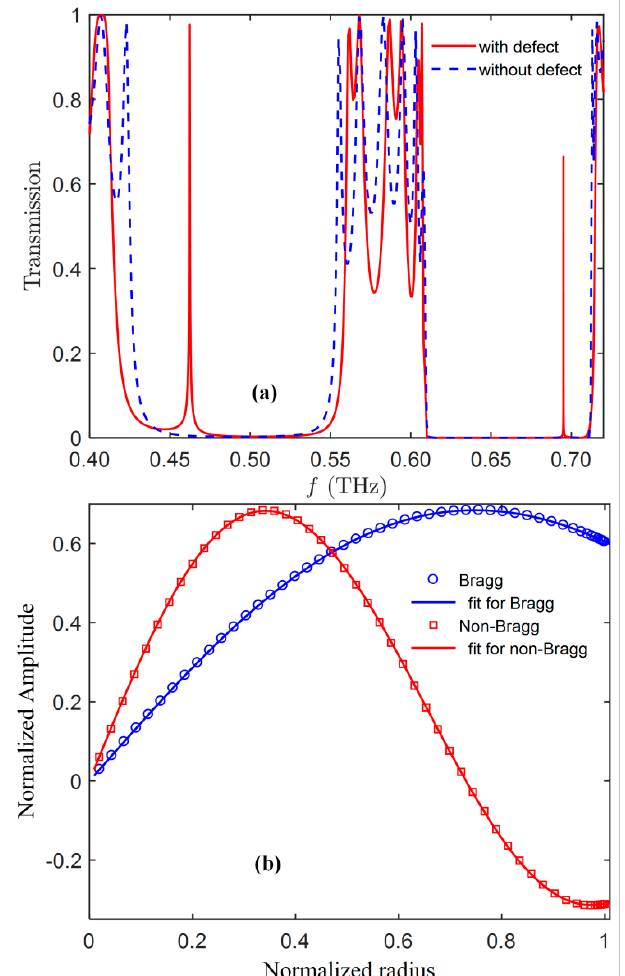
Figure 2. ( a ) Comparison of Bragg and non-Bragg stop-bands, with and without defects: red solid line = transmission curve for the waveguide with defects; blue dashed line = transmission curve for the waveguide without defects. ( b ) Radial distributions for the Bragg and non-Bragg defect states: red squares = normalized magnetic field strengths for the NBDS; blue circles = normalized magnetic field strengths for the Bragg defect state. The blue and red solid lines show the best fitting curves.